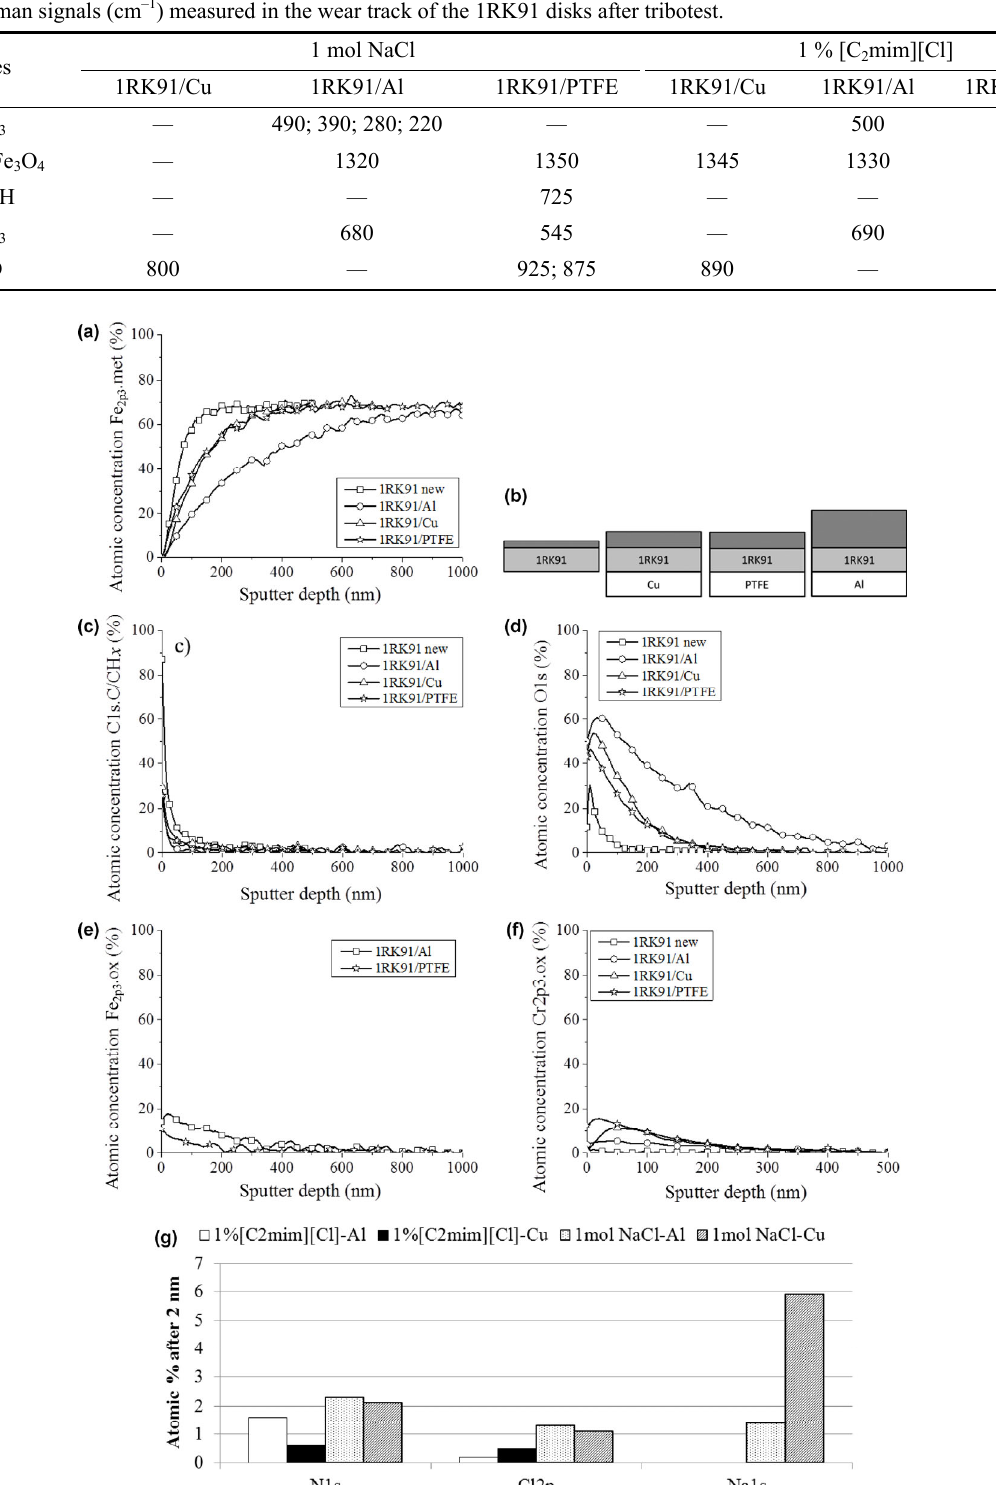
Fig. 7 XPS-analysis (sputter rate ≈ 10 nm/min) of new 1RK91 material and wear scars on the disks after tribotest (10 N, 20 Hz, RT, 1 mm, 1 h) using [C 2 mim][Cl] with the different material combinations, e.g. polarizations: (a) metallic Fe 2 p 3 ; (b) schematically illustration of tribo-layer thickness on 1RK91 after tribo-test; (c) C1s.C/CH x ; (d) O1s; (e) Fe 2 p 3 oxide; (f) Cr 2 p 3 oxide; (g) result of high resolution analysis of the first 2